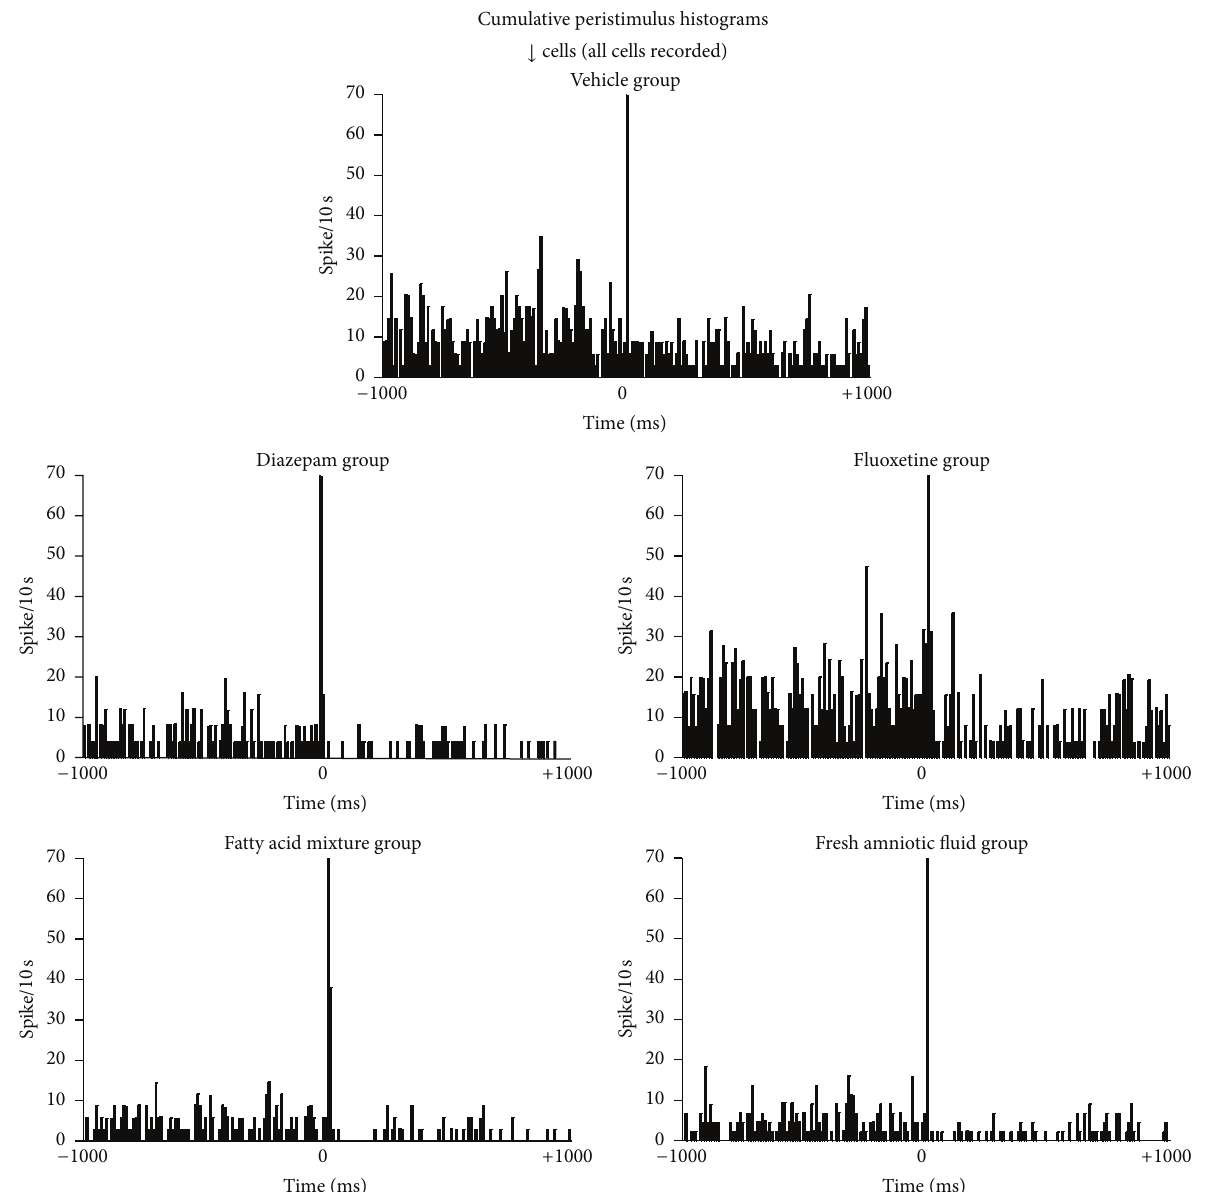
Figure 4: Cumulative peristimulus histogram for septal neurons that responded with a decreased firing rate after amygdala stimulation ( ↓ cells). The response was similar among treatments. The coordinates are the same as in Figure